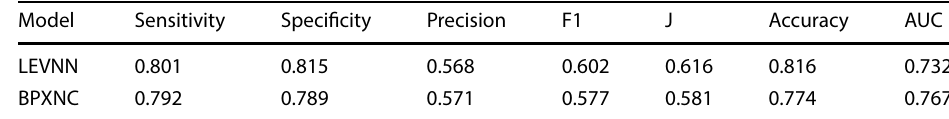
Table 9 ANN performance (testing)